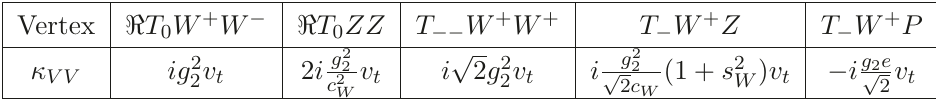
Table 4 . Feynman rules for TV V vertices. The g µν factors are